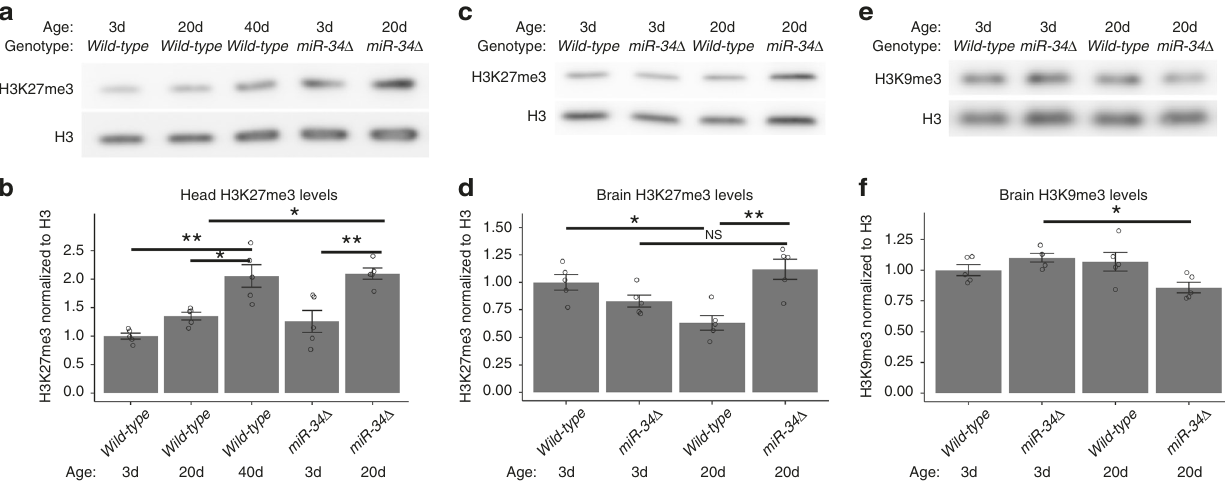
Fig. 4 H3K27me3 levels with age and in miR-34 mutants. a , b H3K27me3 levels with age in heads. Total histone was puri fi ed from Drosophila heads at 3d, 20d, and 40d. H3K27me3 gradually increased with age, and increased faster in miR-34 mutants. Histone H3 is a control for total H3 levels. Quanti fi cation of relative levels of H3K27me3 was normalized to the total histone H3. Mean ± SEM, n = 5 biological replicates. Signi fi cant main effects were observed (genotype: F 1,20 = 13.5, p < .01, age: F 2,20 = 18, p < .001). (* p < 0.05, ** p < 0.01 two-way ANOVA, with Tukey post-test). c , d H3K27me3 levels are increased in the brain of aged miR-34 mutants. Protein samples were derived from dissected brains. H3K27me3 protein levels are normalized to total Histone H3 levels. Mean ± SEM, n = 5 biological replicates. Signi fi cant interaction and main effect were observed (genotype: F 1 , 16 = 4.7, p < .05, age: F 1, 16 = 0.28, ns, interaction: F 1, 16 = 2.06, p < .001. (* p < 0.05, ** p < 0.01 two-way ANOVA with Tukey post-test). e , f H3K9me3 levels are affected in miR-34 mutants. Protein samples from dissected brains. H3K9me3 levels were normalized to total histone H3. Mean ± SEM, n = 5 biological replicates. A signi fi cant interaction was observed (interaction: F 1 16 = 8.76, p < 0.01, genotype: F 1,16 = 1.1, p > .05, age: F 1,16 = .2.7, p > .05). (* p < 0.05, two-way ANOVA,